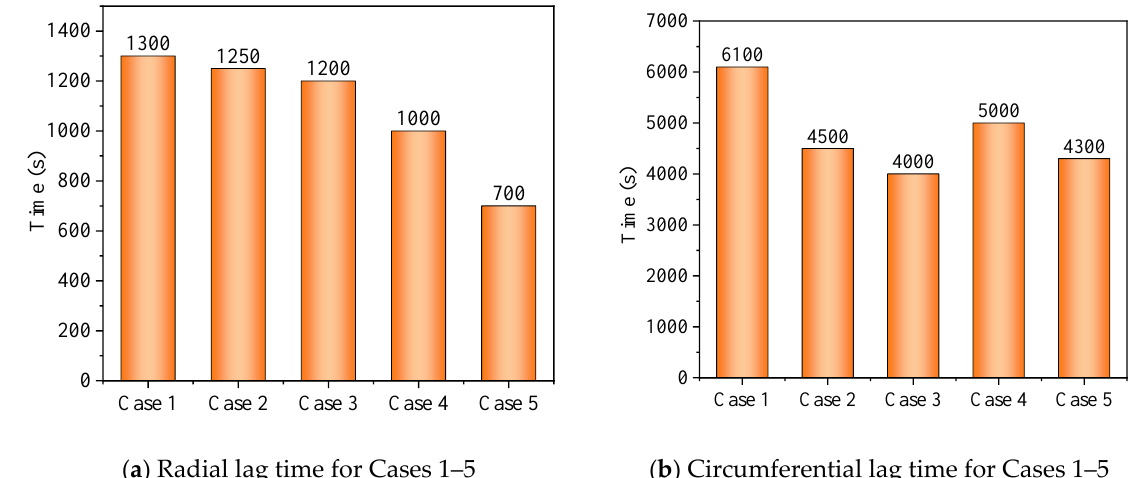
Figure 12. Thermal penetration and thermal uniformity for Cases 1 – 5.